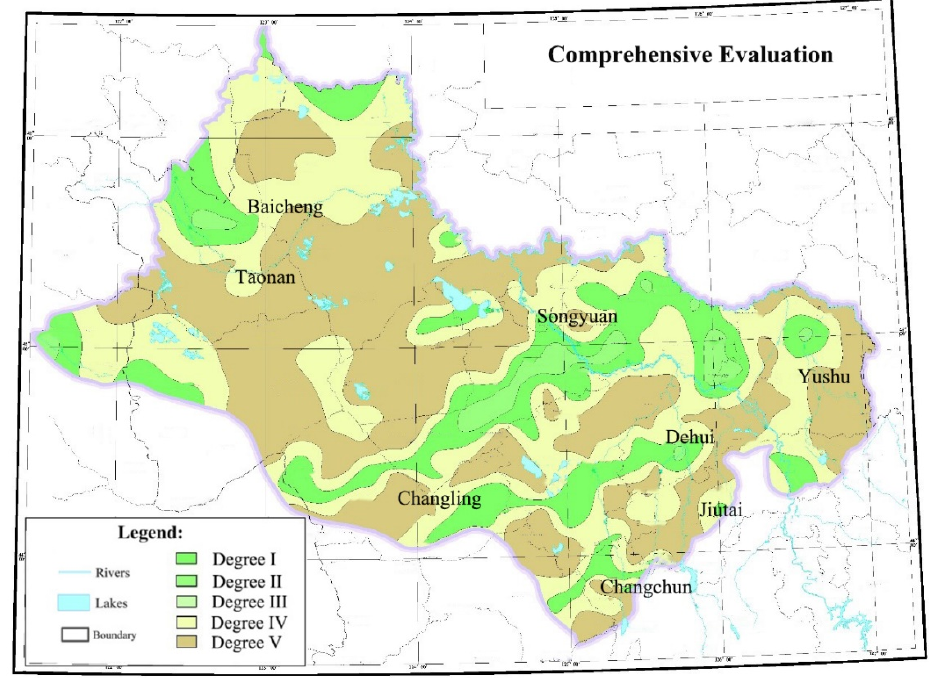
Figure 3. Map of comprehensive quality assessment.